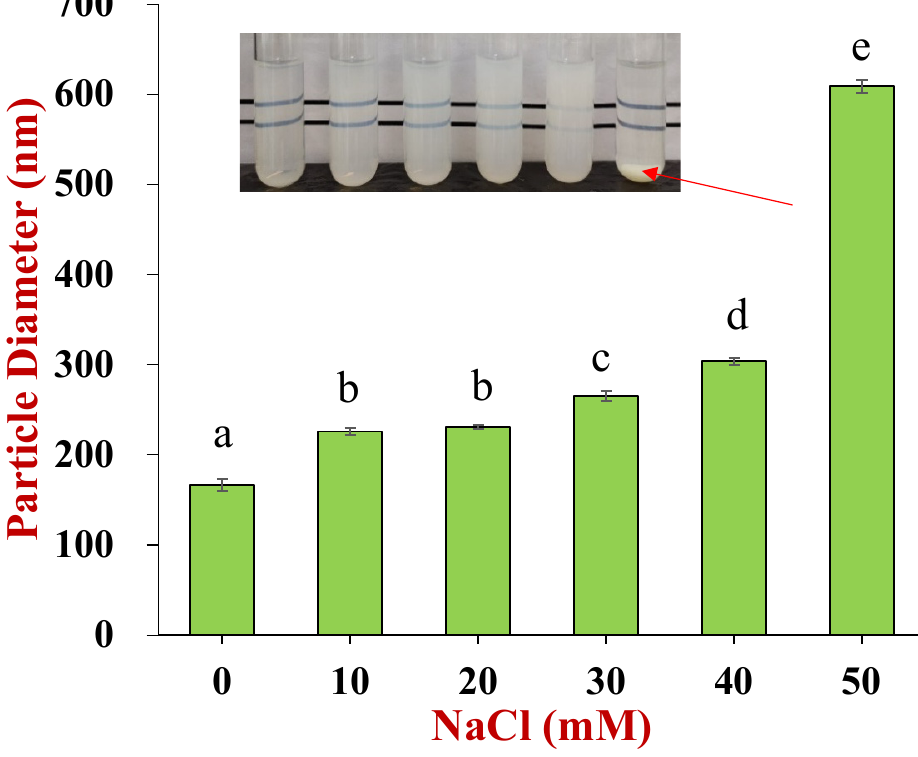
Figure 5. Effect of NaCl concentrations on nanoparticle stability. The inserted photo indicates that the appearance of nanoparticle dispersions changed with NaCl concentrations ranging from 0 to 50 mM (the letter “a-e” represents a statistically significant difference between two groups, p < 0.05).